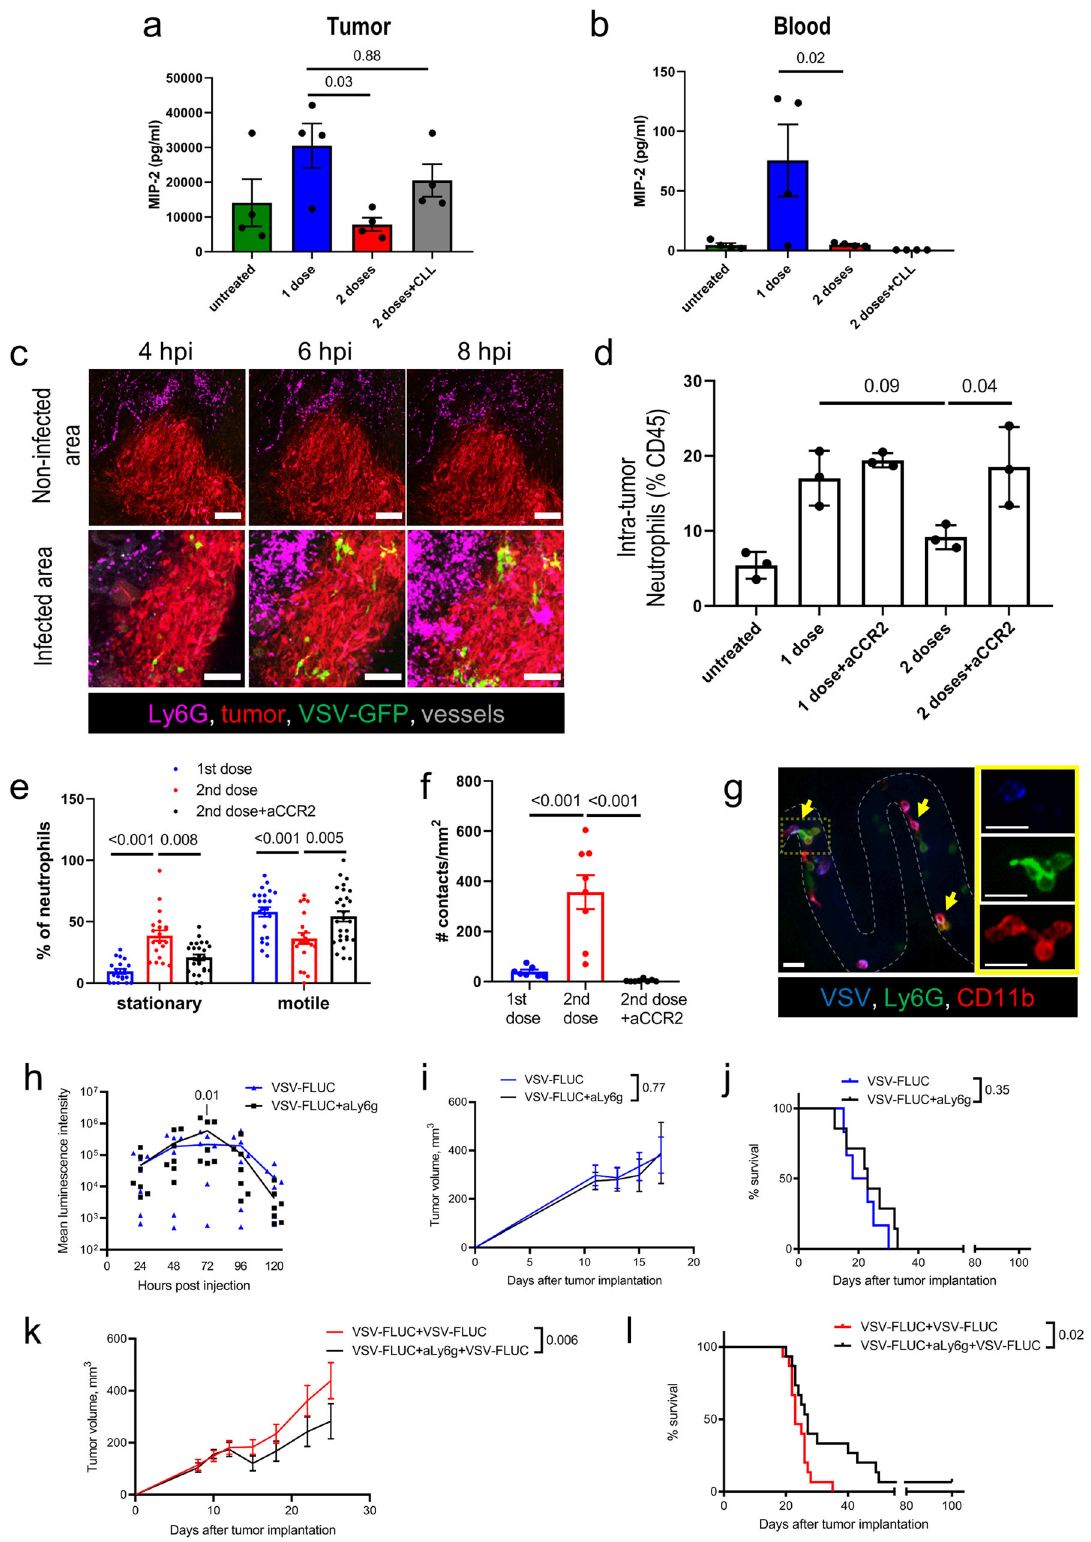
mediated activation of monocytes is central to the antitumor effects of the repeat viral dose. Intravascular monocytes rapidly bind circulating second dose OV and initiate sustained interac- tions with intravascular neutrophils, resulting in reduced neu- trophil in fi ltration of the tumor. This reduction in intratumoral neutrophils leads to sustained viral infection of the tumor.